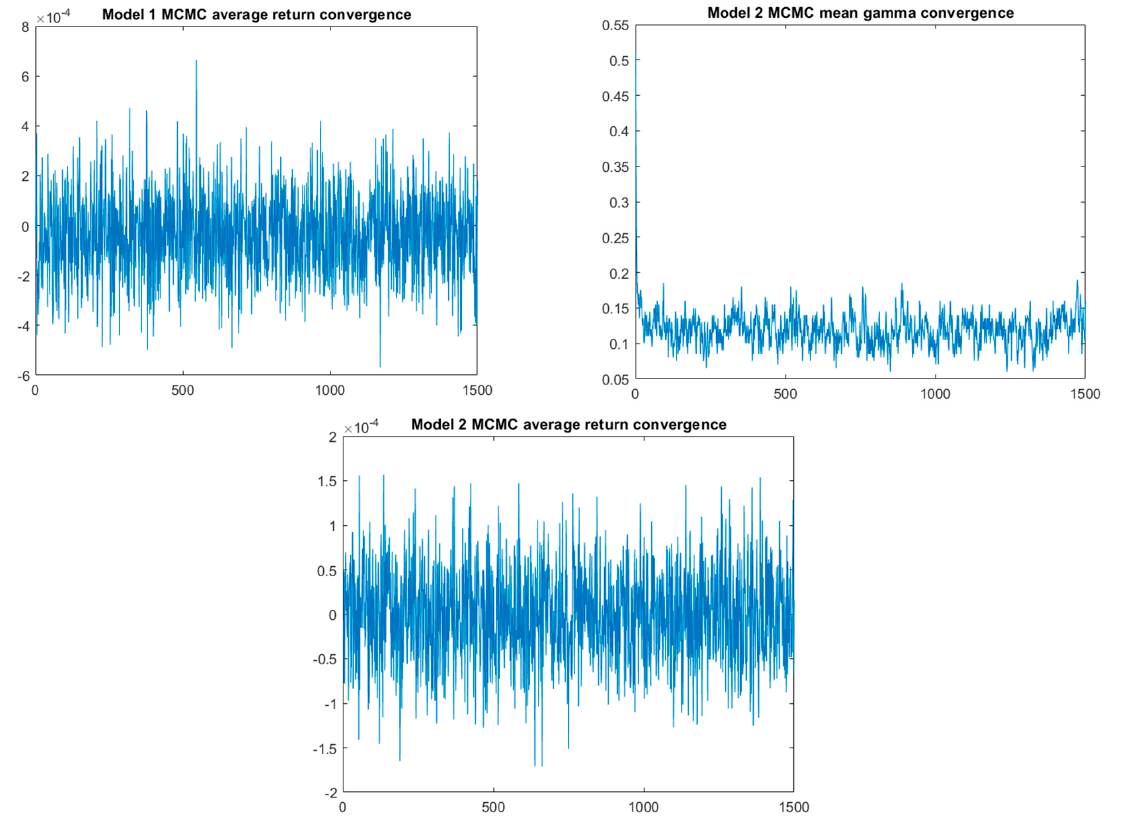
Figure A1. MCMC convergence diagnostics for the Models 1 and 2.